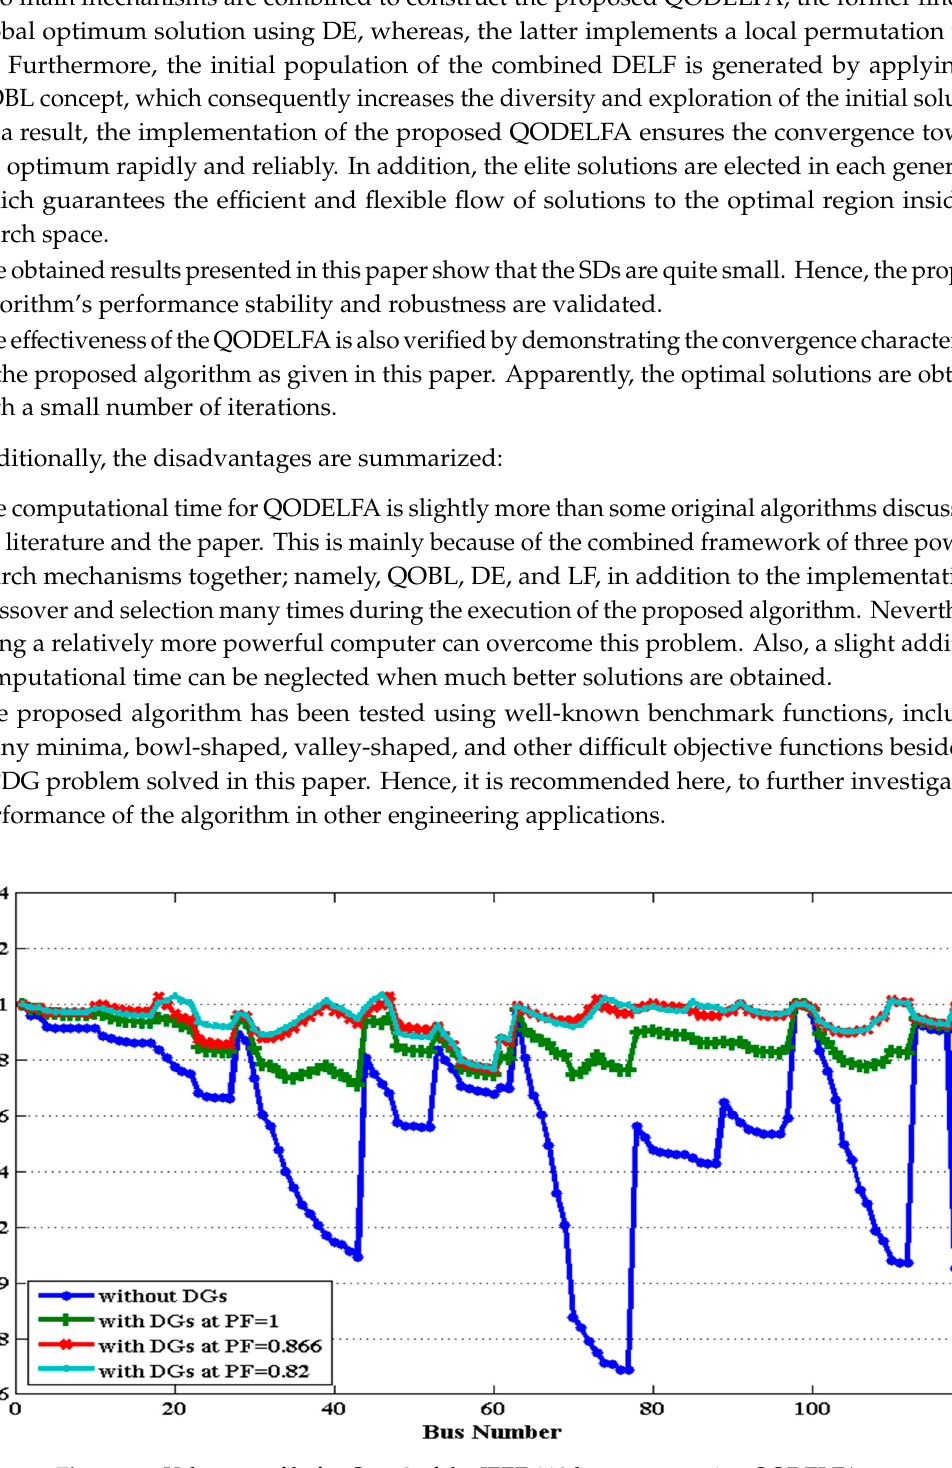
Figure 18. Voltage profile for Case 3 of the IEEE 118-bus system using QODELFA.